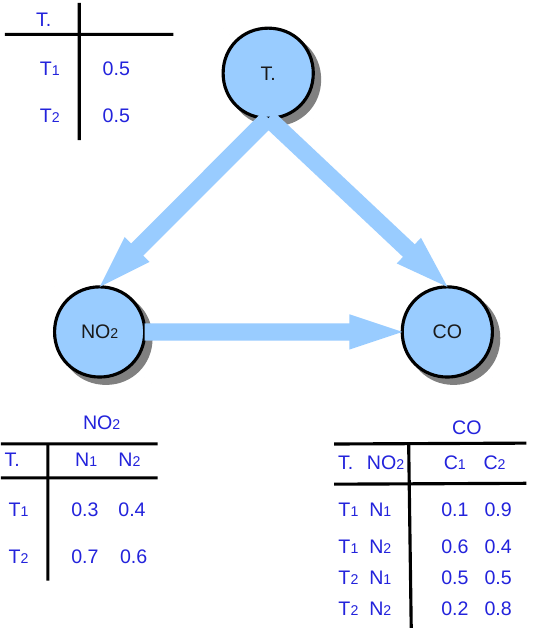
Figure 2. An example of a Bayesian belief network. Each sensor’s readings can be discretized into N values, with each discrete value denoted as T n , C n , and NO n , respectively.